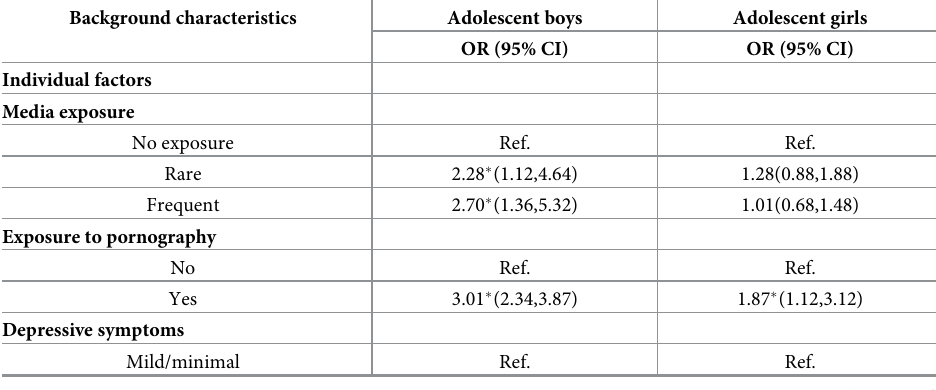
Table 3. Logistic regression estimates for early sexual debut among unmarried adolescents by background